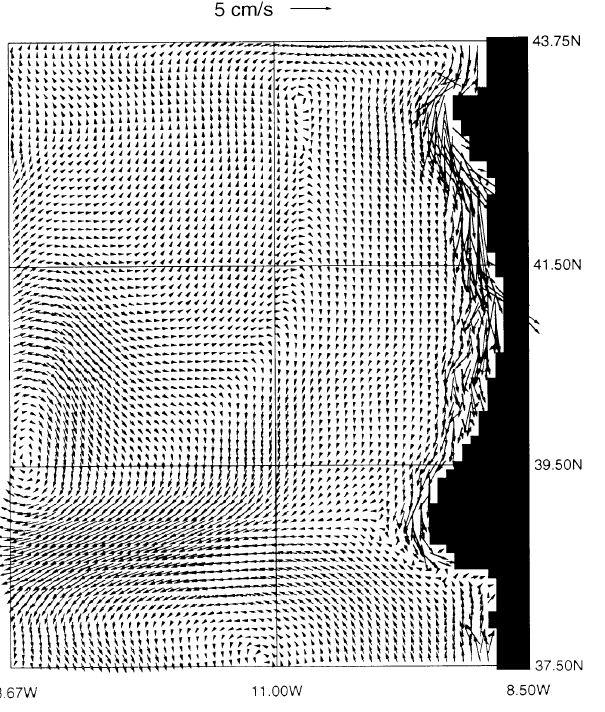
Fig. 3. Winter velocity field at level 2 (32 m) for case A with Sver- drup boundary stream function, annual mean surface and boundary relaxation of tracers, and driven by Hellerman and Rosenstein winds